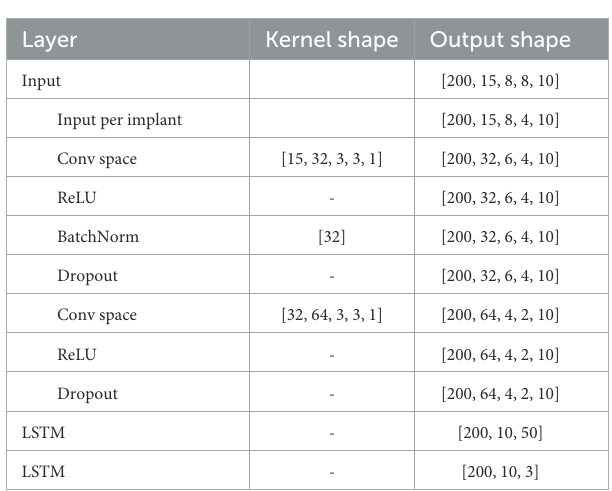
TABLE 1 MLP architecture from ´Sliwowski et al. (2022). TABLE 2 CNN+LSTM+MT architecture from ´Sliwowski et al.